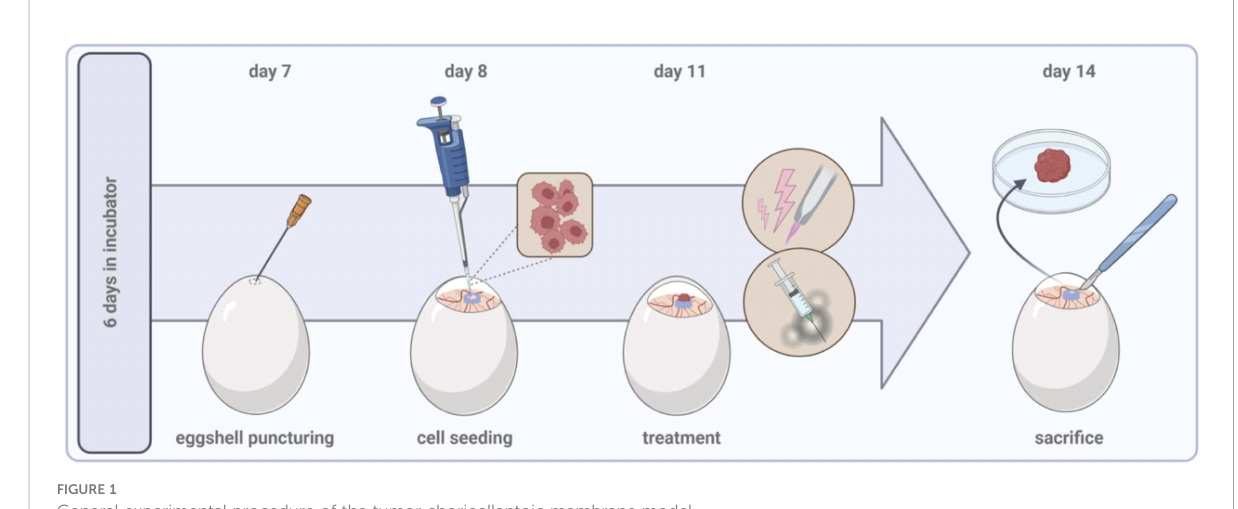
FIGURE 1 General experimental procedure of the tumor chorioallantoic membrane